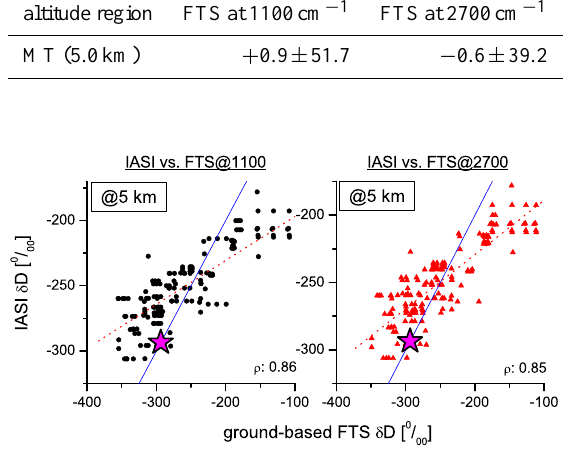
Fig. 14. Same as Fig. 13 but for δ D and only for an altitude of 5 km.